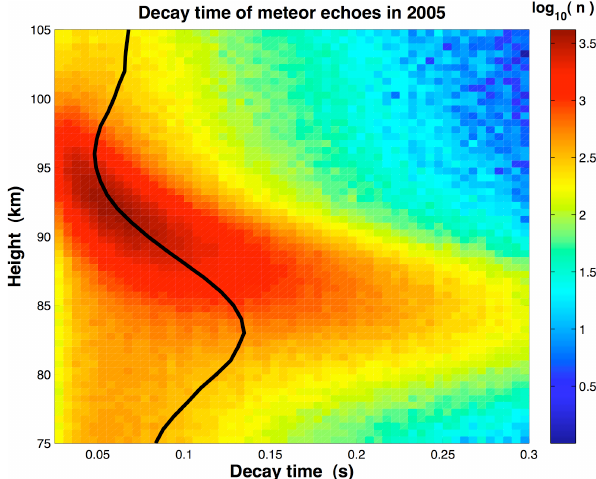
Fig. 1. Decay time versus height of all meteors during 2005. Color shading indicates the number of meteors, n (per 500m × 5ms win- dow). The solid line indicates the mean decay